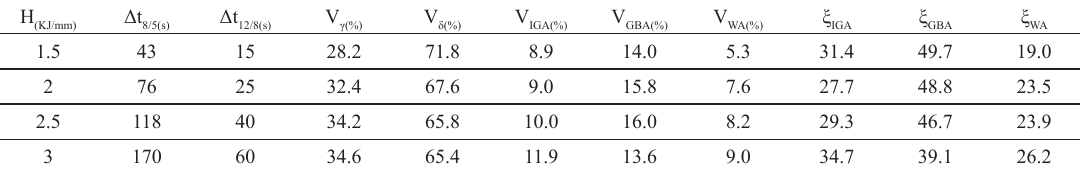
) and ferrite (V ) volume fractions at different cooling times at the HAZ microstructures of the UNS S31803 Table 2. Austenite (V γ δ DSS. . V , V and V are the austenite volume fractions taking into account their morphologies. Heat input (H), the ξ GBA IGA WA ξ are the ratios between the volume fraction of the different austenite morphologies and the total austenite volume fraction. WA